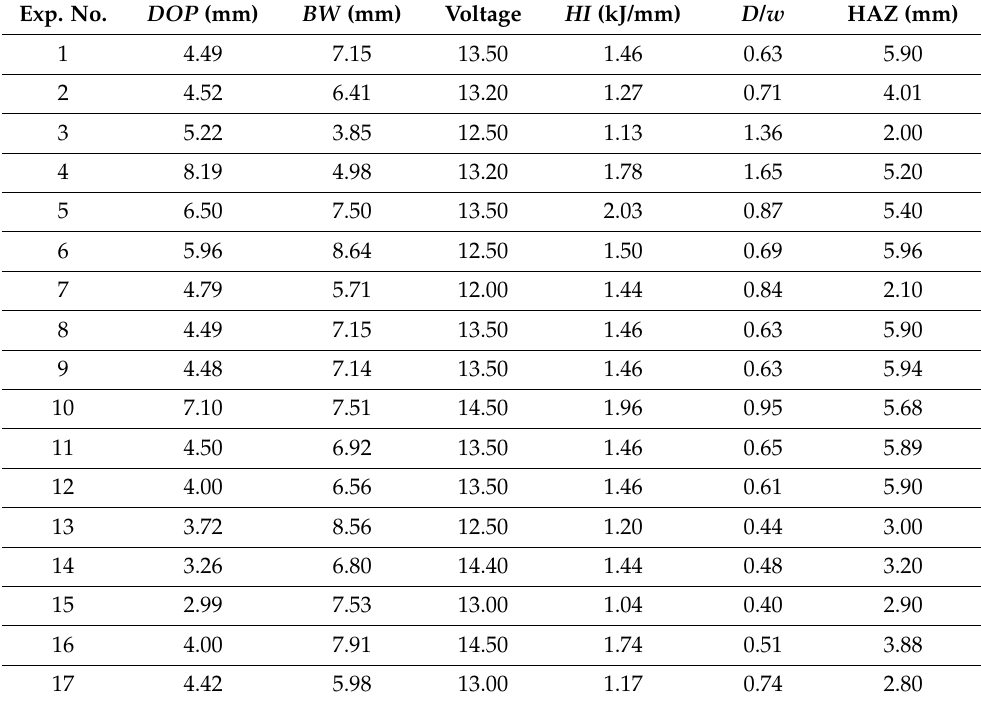
Table 5. Experimentally measured